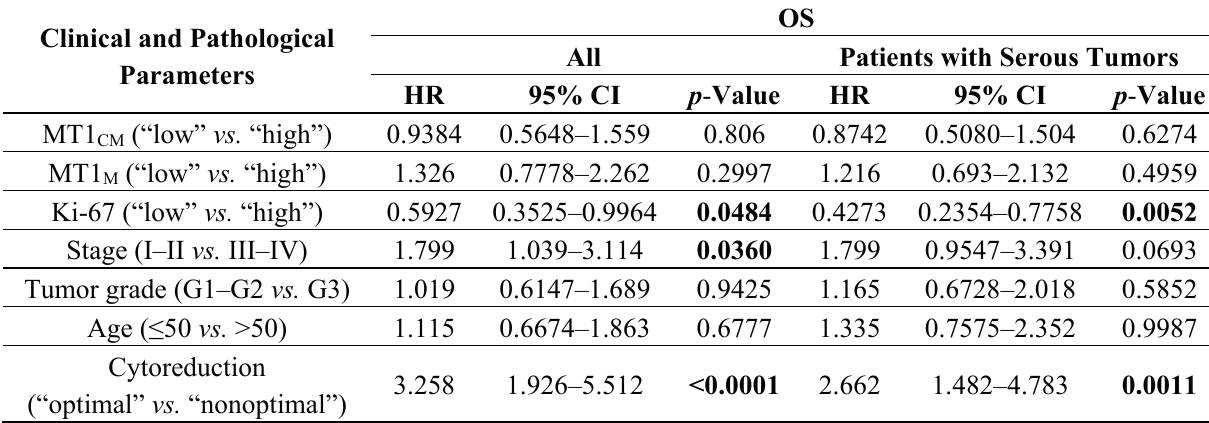
Table 1. Univariate Cox proportional hazard analysis in 84 patients with ovarian cancer. Clinical and